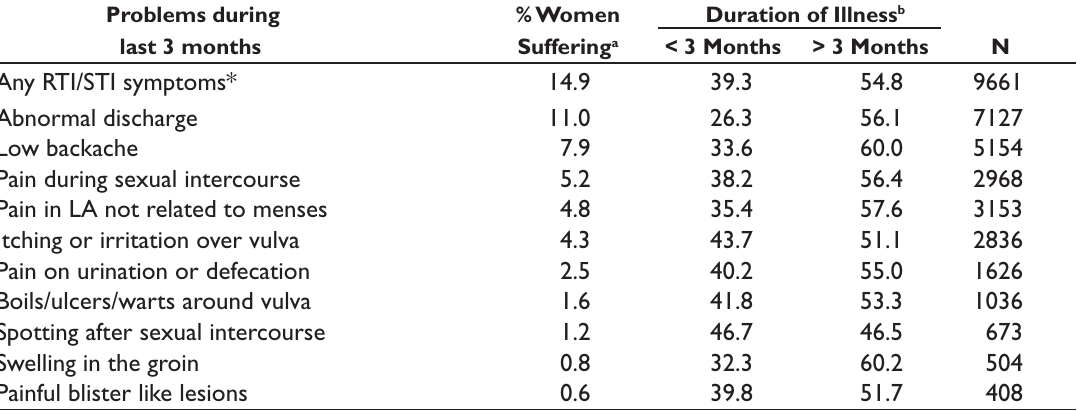
Percentage of adolescent married women reporting different symptoms of RTIs/STIs and the duration of the illness, India, 2007-08